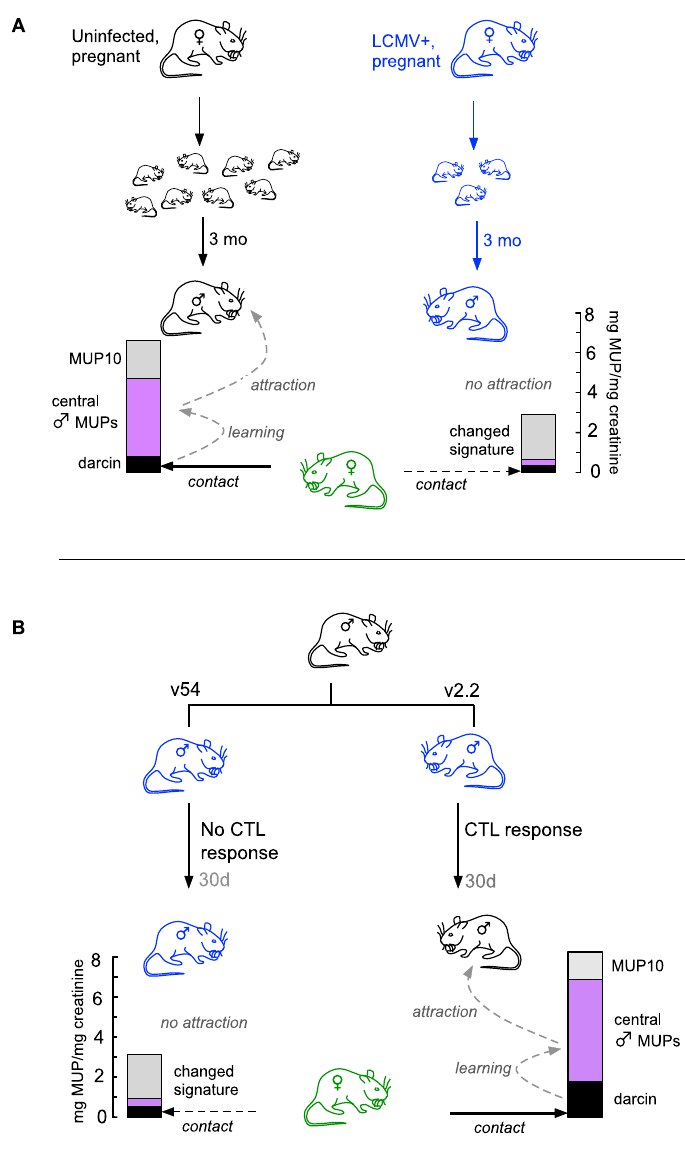
Figure 6. Effects of LCMV infection on male MUP expression and expected influence on female attraction. The cartoon depicts MUP signals produced by males that are infected with LCMV (blue mice) or uninfected/recovered from LCMV infection (black mice), with the predicted response of an adult female prospecting for a mate (green mice). Bars indicate the amount of darcin (black), male-biased central MUPs (purple) and central MUP10 (grey) produced by males of each type (data are mean mg MUP/mg creatine produced by singly housed C57BL/6 males in this study). ( A ) Fewer offspring survive from infected mothers and carry persistent infection with very weak male MUP signals when adult. Uninfected males produce much stronger MUP signals, including a central MUP signature and darcin, which stimulates females to contact scent and learn attraction to the individual owner. ( B ) Males that are able to clear LCMV infection gained in adulthood produce much stronger MUP signals including an individual signature and darcin, stimulating females to contact and learn attraction to the individual owner. See text for further